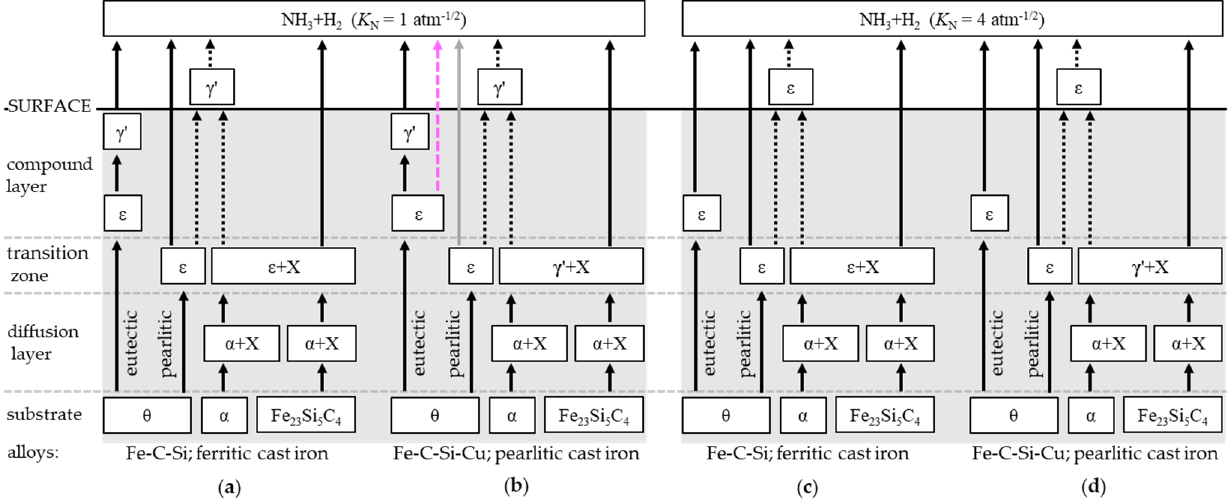
Figure 6. Schematic description of phase formation during nitriding (540 °C, 16 h) with ( a , b ) K N = 1 atm − 1/2 and ( c , d ) K N = 4 atm − 1/2 as a function of local microstructural constituents ( θ —eutectic and pearlitic cementite, α —ferrite, Fe 23 Si 5 C 4 —silicocarbide) of white-solidified: ( a , c ) Fe-C-Si and ferritic cast iron alloys; ( b , d ) Fe-C-Si-Cu and pearlitic cast iron alloys with <0.2 wt% Mn. For pearlitic cast